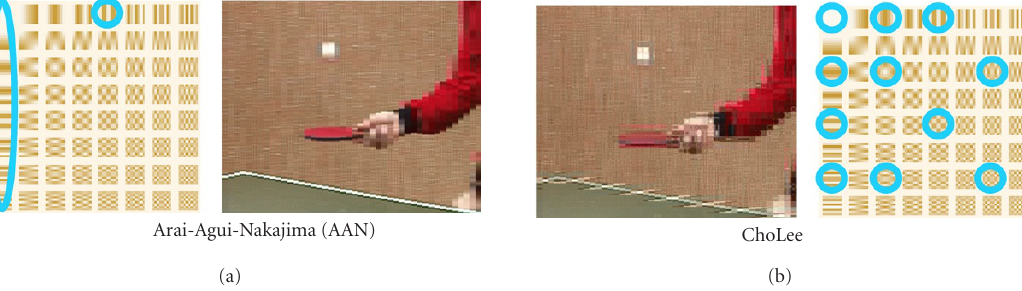
Figure 15: Example of scaled AAN-DCT (a) and ChoLee-DCT (b) at 256 operations. AAN fits better for horizontal edges, while ChoLee has better results for the